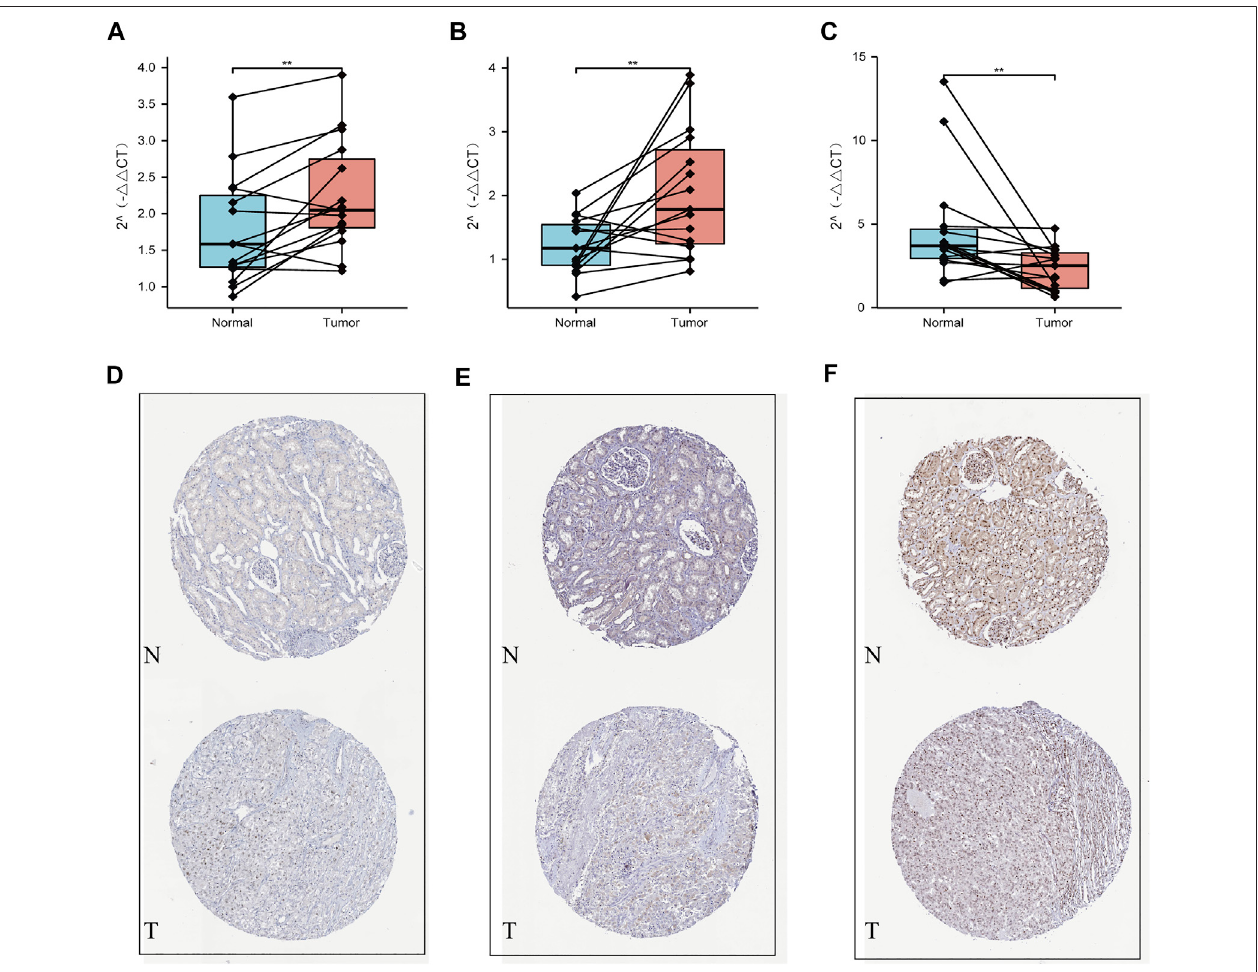
FIGURE9| ValidationusingqPCRandHPAdatasets. (A) NOP2, (B) NSUN6,and (C) TET2mRNAexpressionmeasuredbyqRT-PCR.Validationofthedifferences in expression of (D) NOP2, (E) NSUN6, and (F) TET2 between renal cancer and normal renal tissue at the translational level with data from the HPA database.